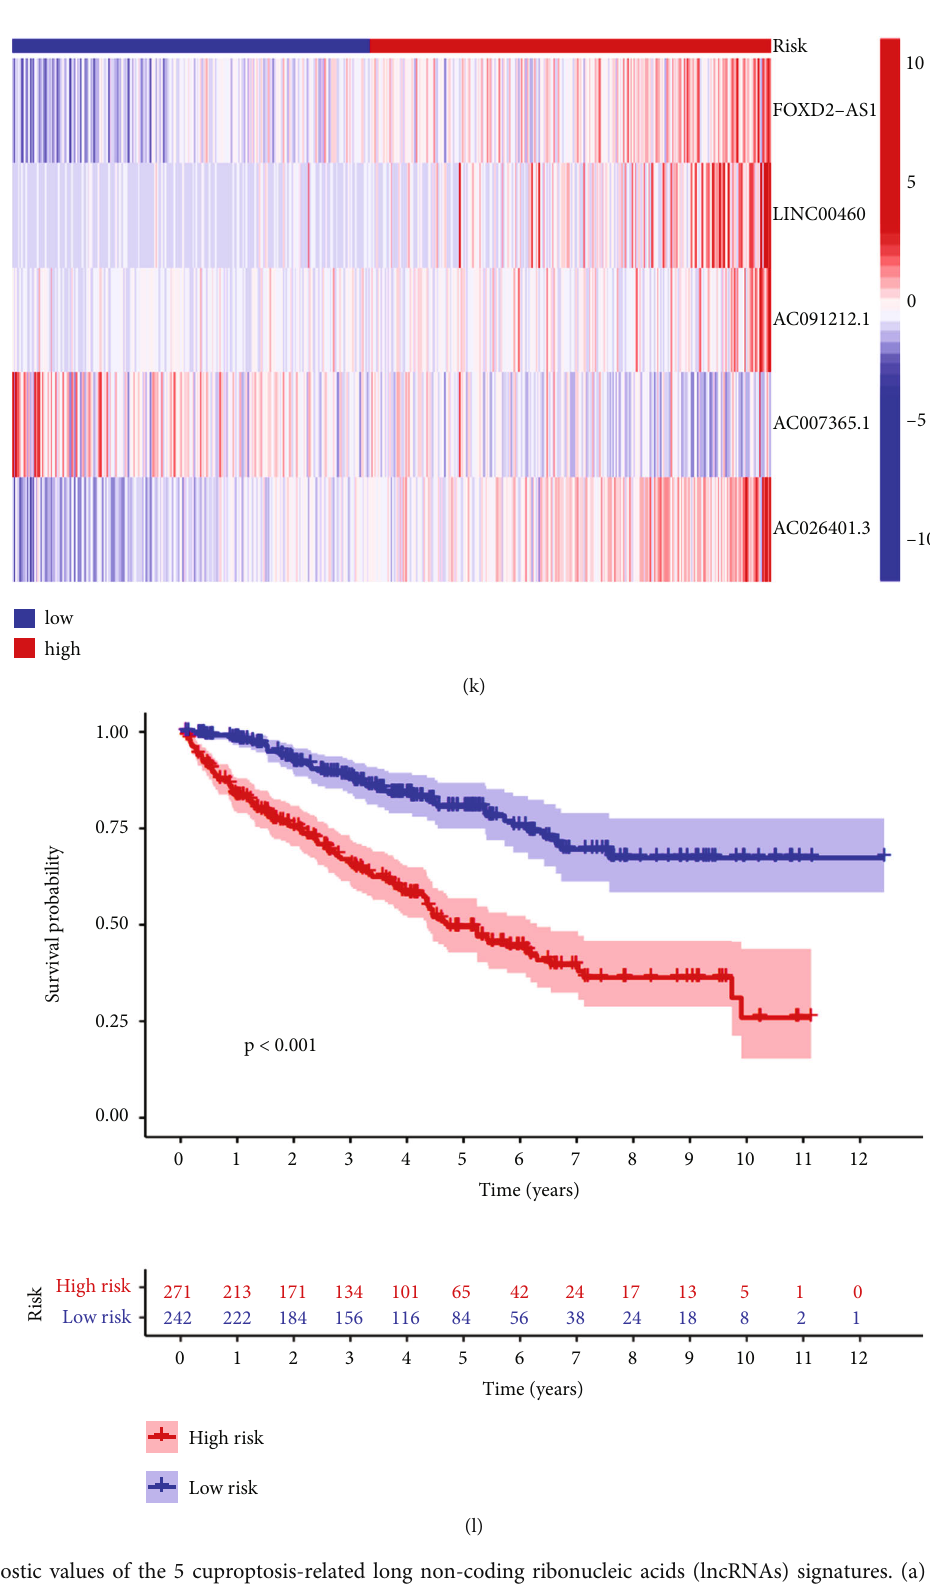
Figure 3: Prognostic values of the 5 cuproptosis-related long non-coding ribonucleic acids (lncRNAs) signatures. (a) Scatter plot of the distribution of risk scores from low to high in the training set. (b) Scatter plot of di ff erent risk scores corresponding to the survival statuses in the training set. (c) Heatmap of lncRNAs expression in the training set patients with di ff erent risk scores. (d) Survival curves of the training set patients. (e), (f), (g), and (h) Corresponding plots in the testing group. (i), (j), (k), and (l) Corresponding plots in the whole